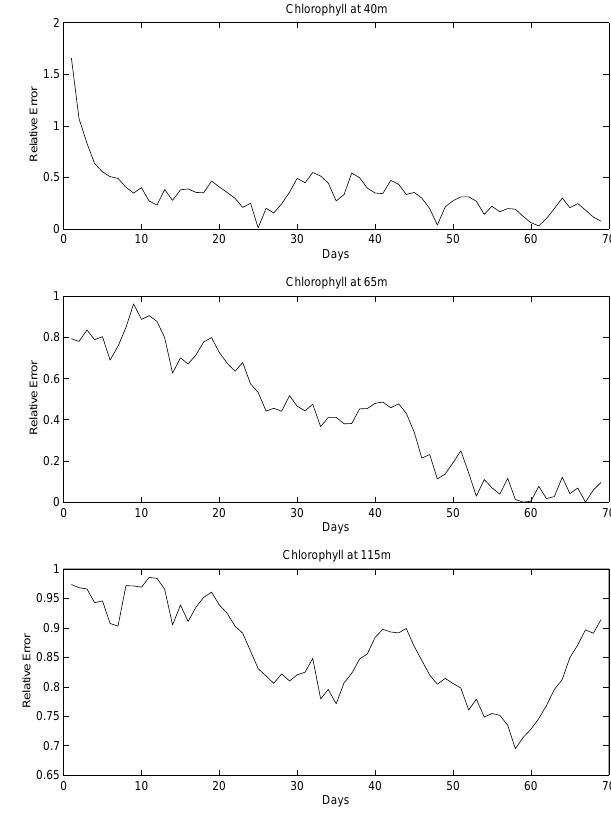
Fig. 5. Simulated chl-a concentrations plotted with in situ val- ues and assimilation results at 40, 65 and 115m for the period of 5 March 2000–12 May 2000 from the experiment with real obser- vations.